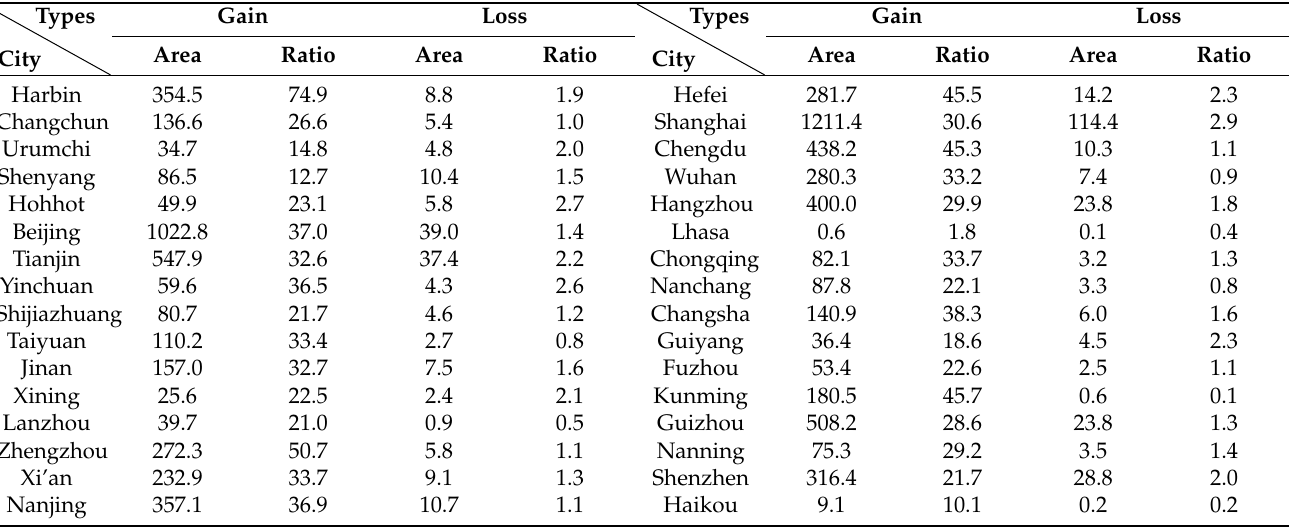
Table 2. Statistical table of artificial surface gains and losses in China’s 32 major cities from 2000 to 2020 (Unit: km 2